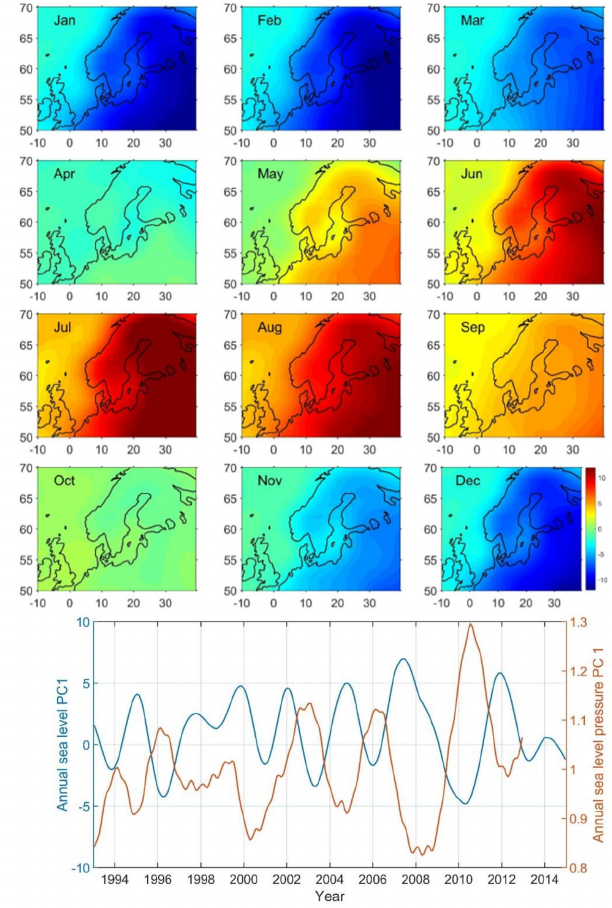
Figure 10. Similar to Figure 4 but for air temperature: monthly time-dependent LVs (K) and PC time series (computed over the region in Figure 1, dimensionless). The PC time series of the annual sea level is